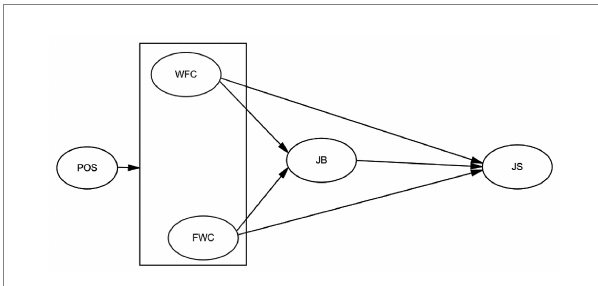
FIGURE 1 Theoretical framework model. WFC, Work Family Conflict;